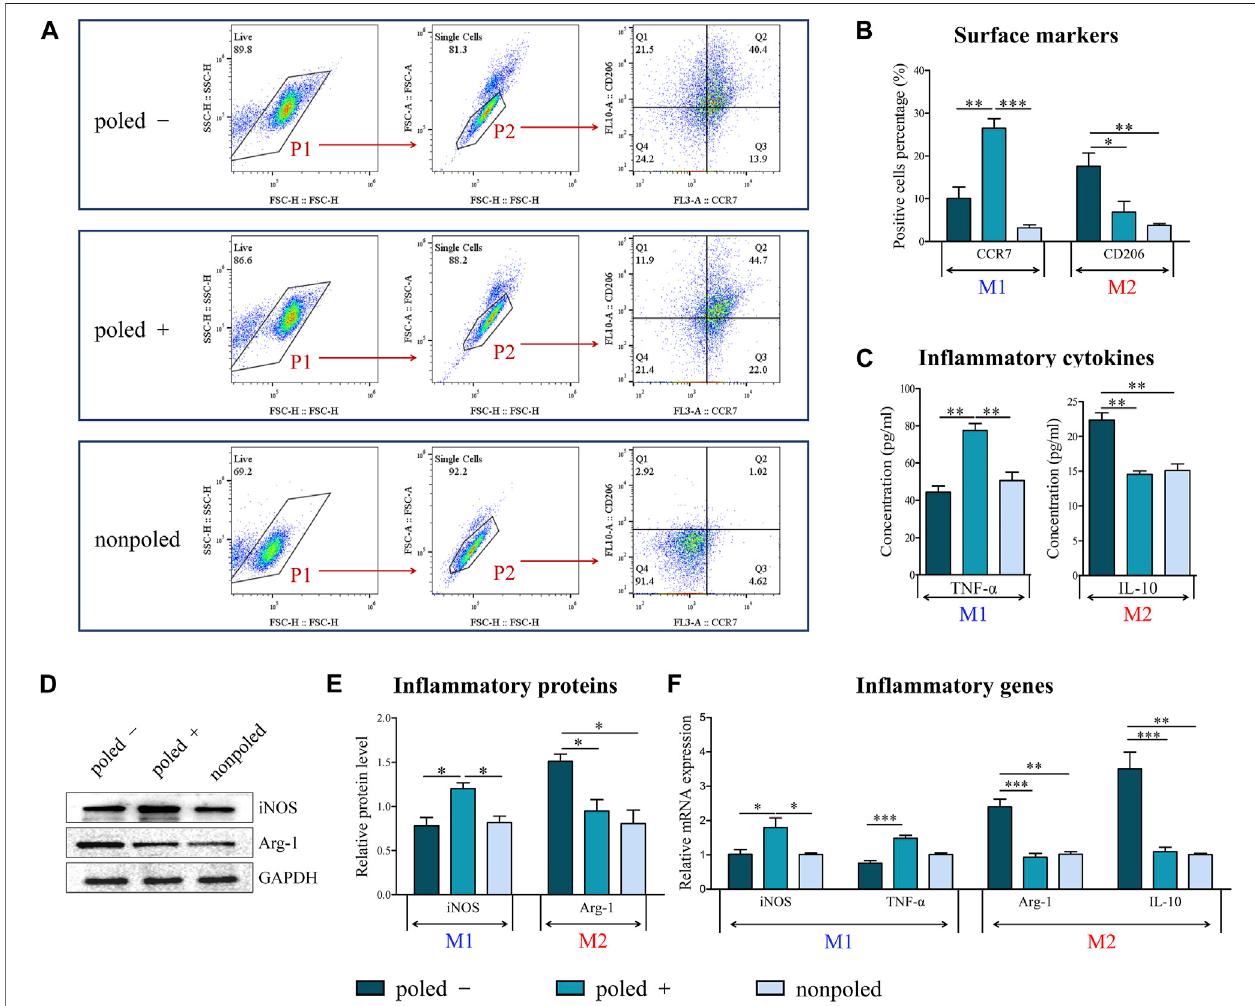
FIGURE 6 | Phenotype analysis of RAW 264.7 macrophages. (A) Flow cytometric analysis of the M1 macrophage marker CCR7 and the M2 macrophage marker CD206. (B) Quantitative analysis of CD206 and CCR7-positive cells by fl ow cytometry analysis. (C) Secretion of in fl ammatory cytokines as measured by ELISA. (D) Westernboltanalysisofthein fl ammatoryproteinsiNOSandArg-1. (E) Quanti fi cationofproteins bywesternblotanalysis(GAPDHserved astheinternalcontrol). (F) The expression of in fl ammatory genes as measured by qRT-PCR ( “ nonpoled ” group as control). * p < 0.05; ** p < 0.01; *** p < 0.001.